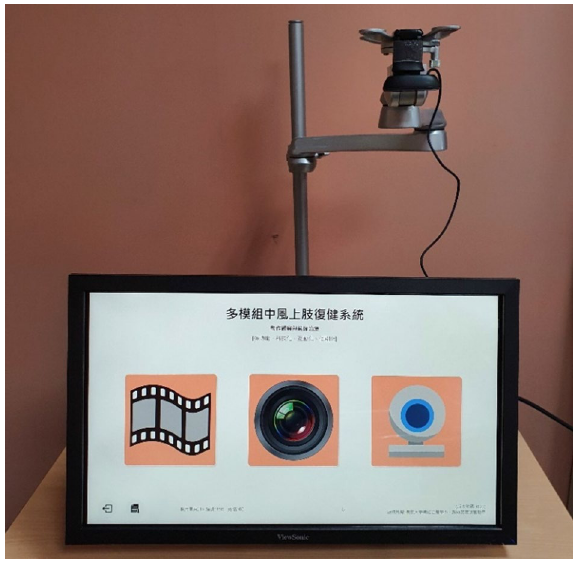
Figure 1. Interface of the multi-mode stroke rehabilitation system of arm and